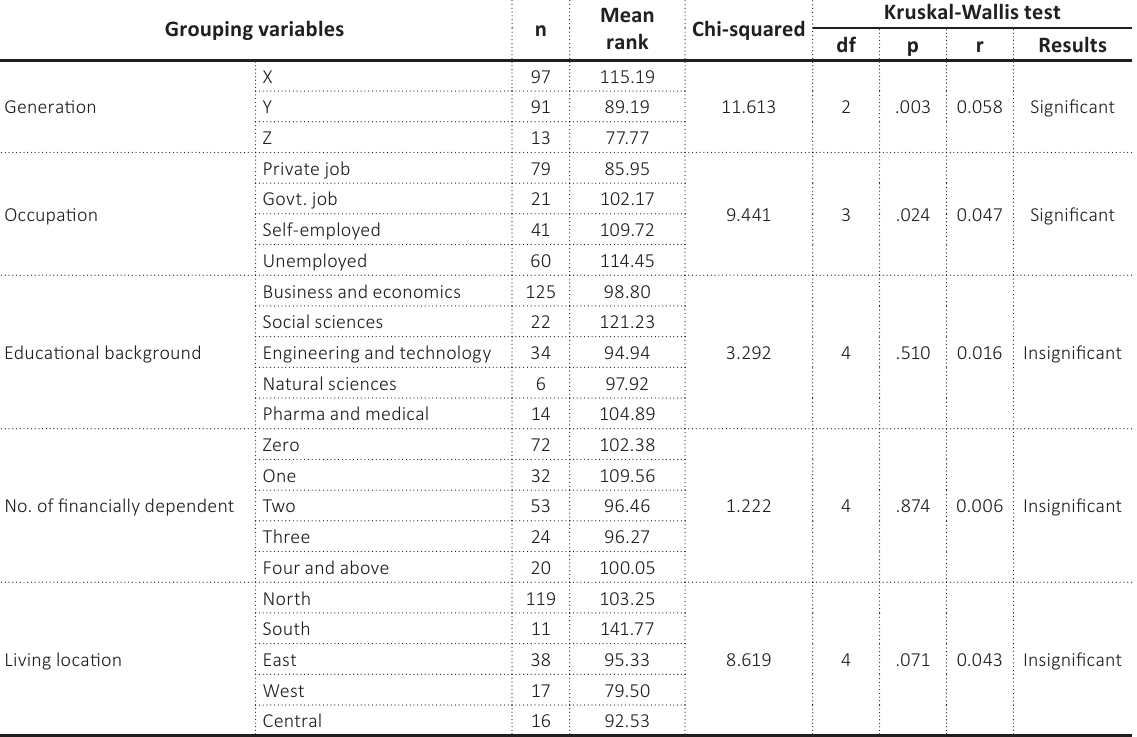
Table 5. Kruskal-Wallis test